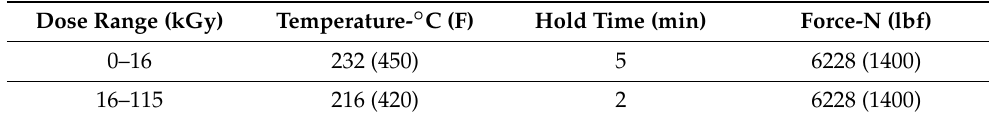
Table 5. Hot press test parameters for porosity approach.